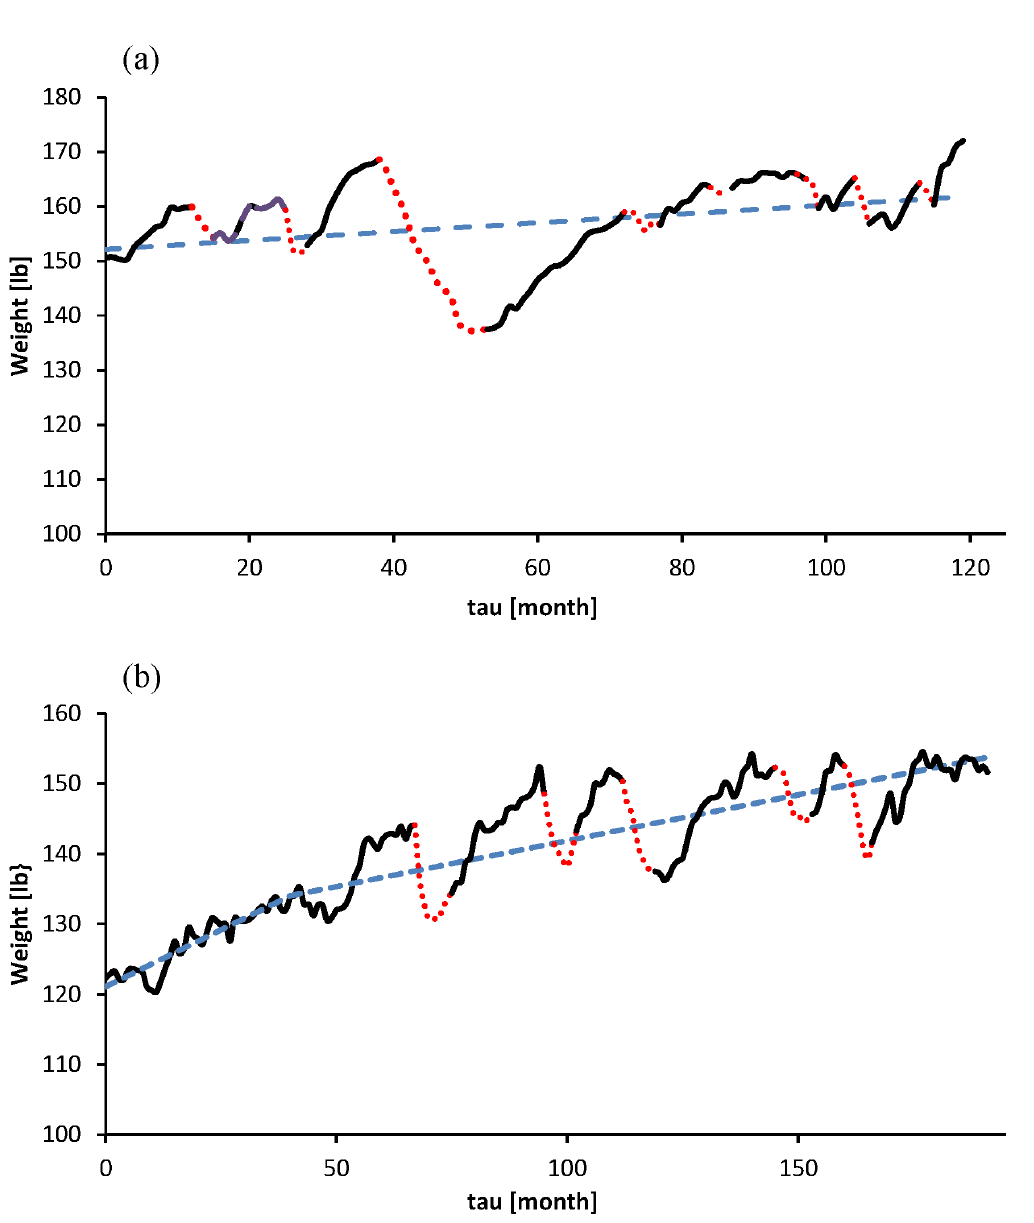
Figure 1. History of weight fluctuations of two adult females from data presented in [ 15 ] . During the period the subjects were taking part in dietary programs (dotted intervals). The dashed lines represent the weight for constant parameter values, see Table 1: (a) Subject A with a mean weight W mean =157.0 [lb]. (b) Subject B with W mean =140.8 [lb]. This history has been split in two sections: up to month 40 with W mean =127.4 [lb] and a second section with W mean =144.4 [lb]. From the first section all parameters are estimated. In the second section these estimates are used again except for the rate of the constant relative decrease e of calorie expenditure which was estimated anew.